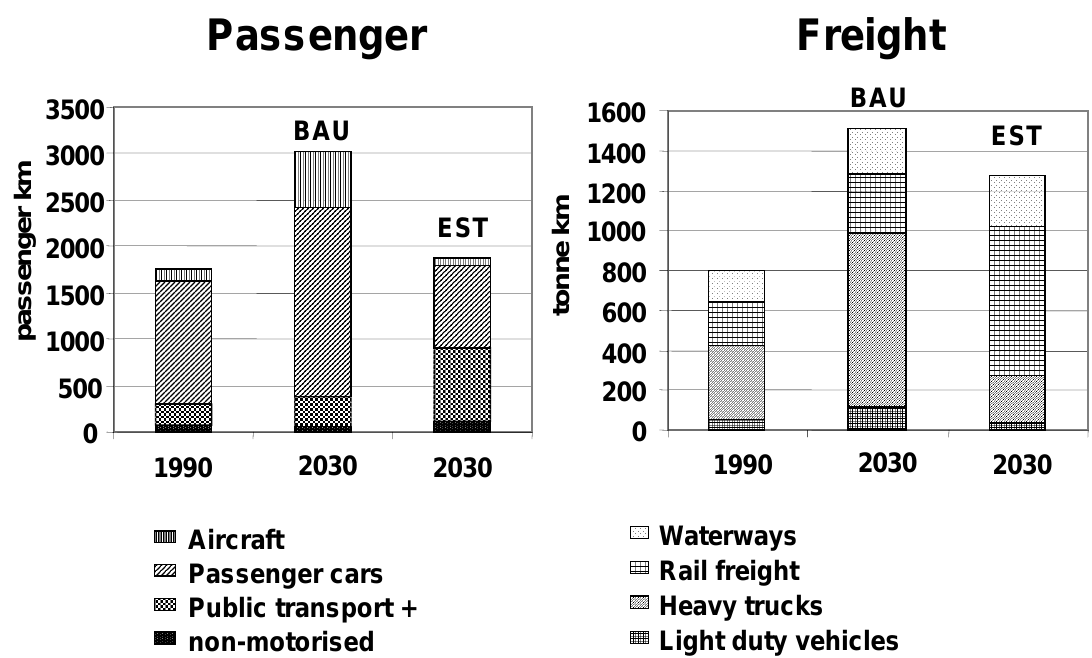
Figure 2. Comparison of transport activity changes in the EST3 scenario and the expected trend (“Business-as-usual”) in 2030 compared to the situation in 1990. Note: Public transport + means new mobility schemes that are practiced in a number of countries,